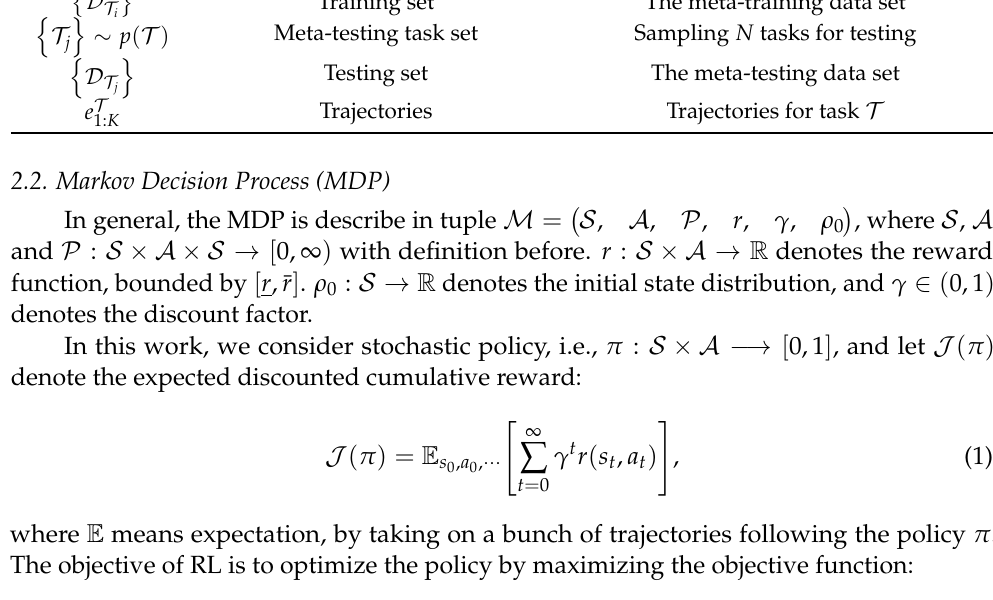
Table 1. Definitions and descriptions of variables used for meta-reinforcement learning. Symbol Functions Description p ( T ) Task distribution Characterize a class of task Task A specific task described by MDP State space p ( T ) shares the same state space Action space p ( T ) share the same action space Transition function space Including varying functions, i.e., different robot dynamics Including varying reward functions, Meta-training task